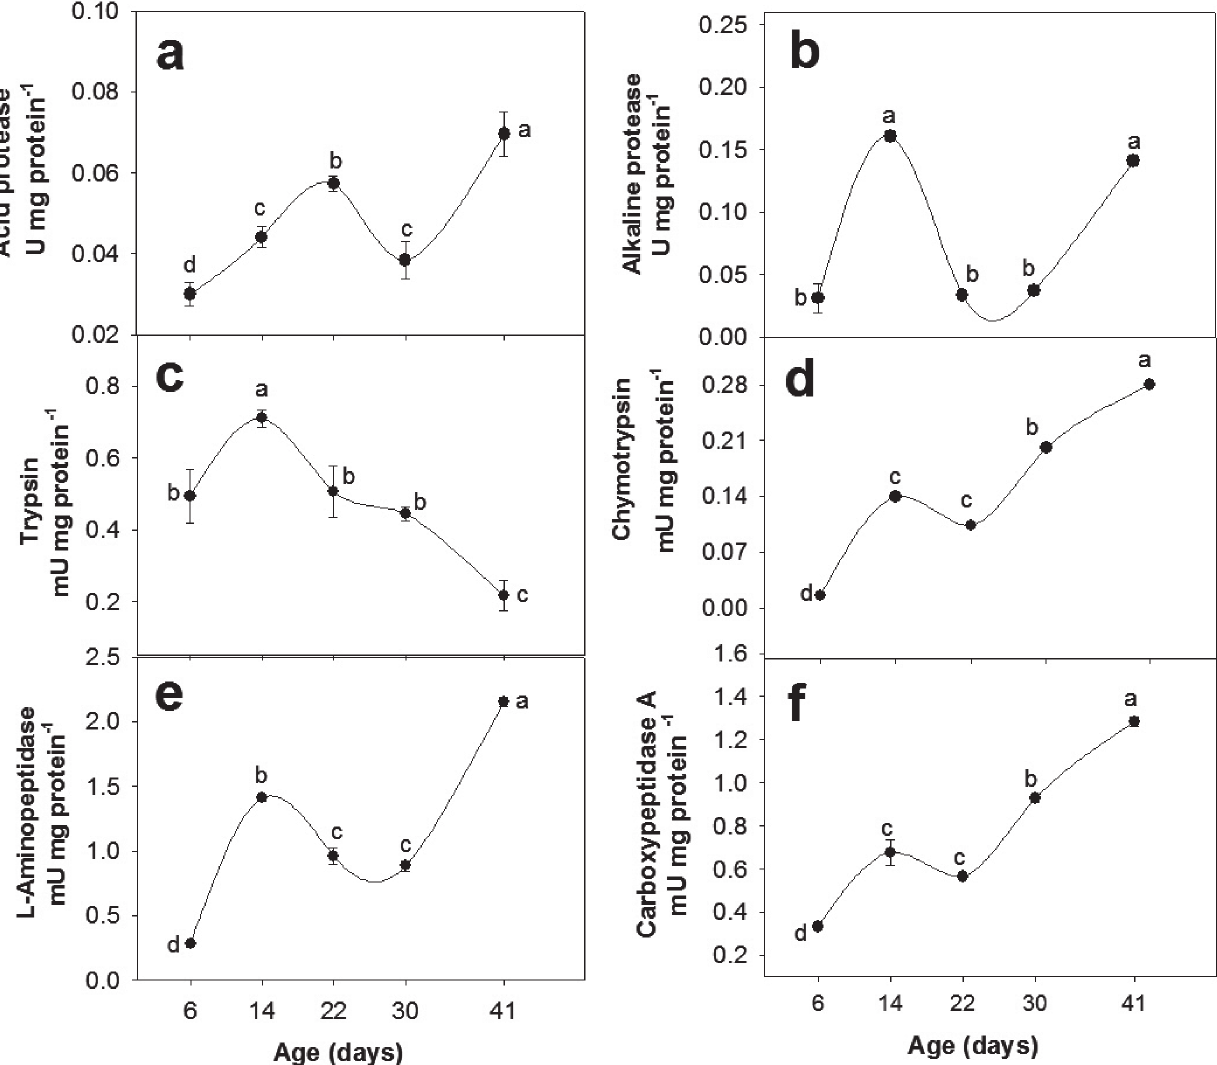
Fig. 2. Digestive proteolytic enzyme activity during ontogeny of Parachromis dovii larvae (means ± SD, n= 3 replicates). (a) specific acid proteolytic activity, (b) specific alkaline proteolytic activity, (c) specific trypsin activity, (d) specific chymo- trypsin activity, (e) specific leucine-aminopeptidase activity, (f) specific carboxypeptidase A